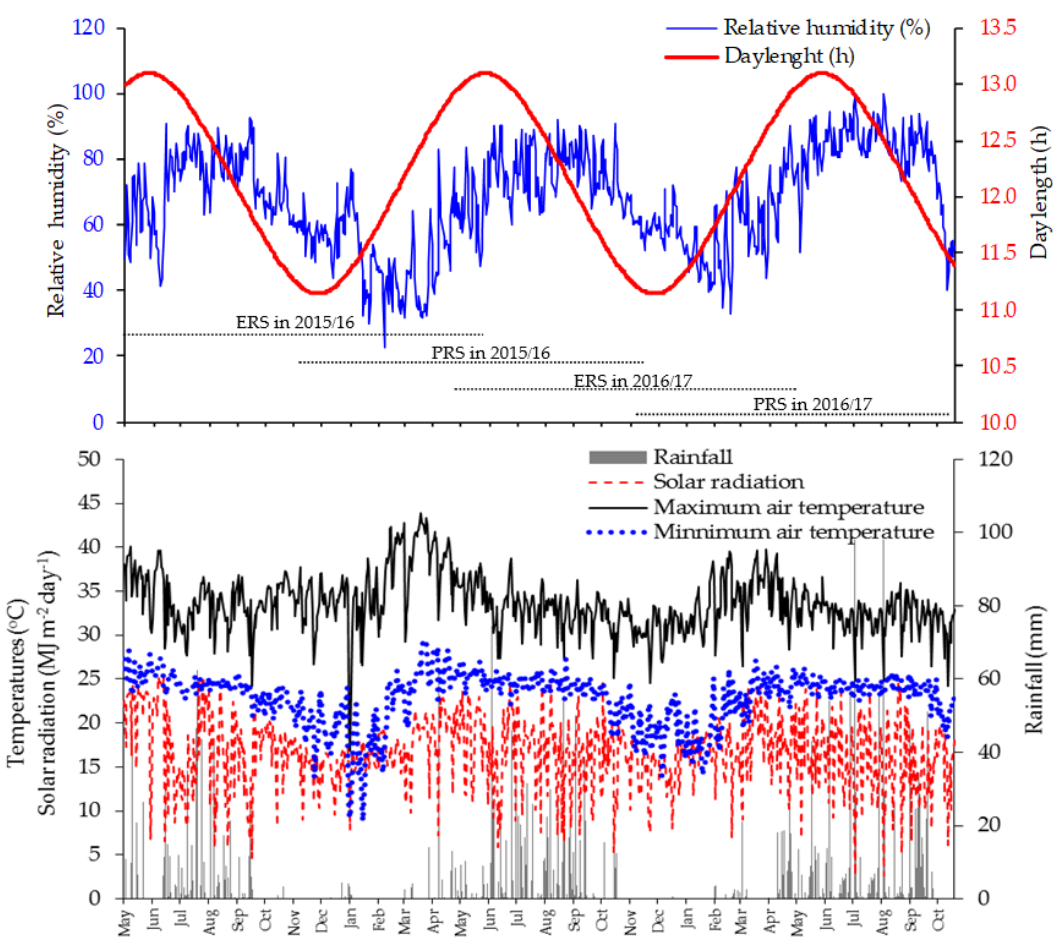
Figure 1. Relative air humidity (%), day-length (h), rainfall (mm), solar radiation (MJ m −2 day −1 ), maximum and minimum air temperatures ( ◦ C) during the crop growth period of cassava. ERS = early rainy season, PRS = post rainy season.